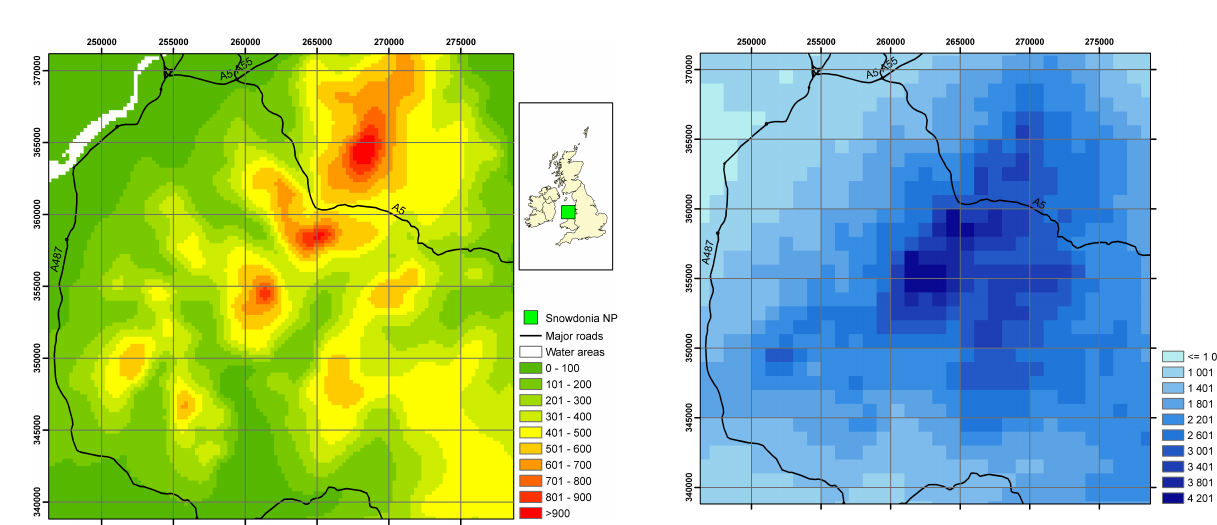
Fig. 1a. Terrain elevation in the region of Snowdonia, North Wales (ma.s.l.).